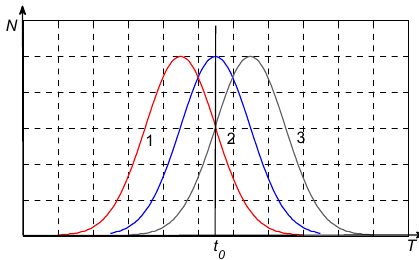
Figure 2. Morphology map of the travel-time distribution.